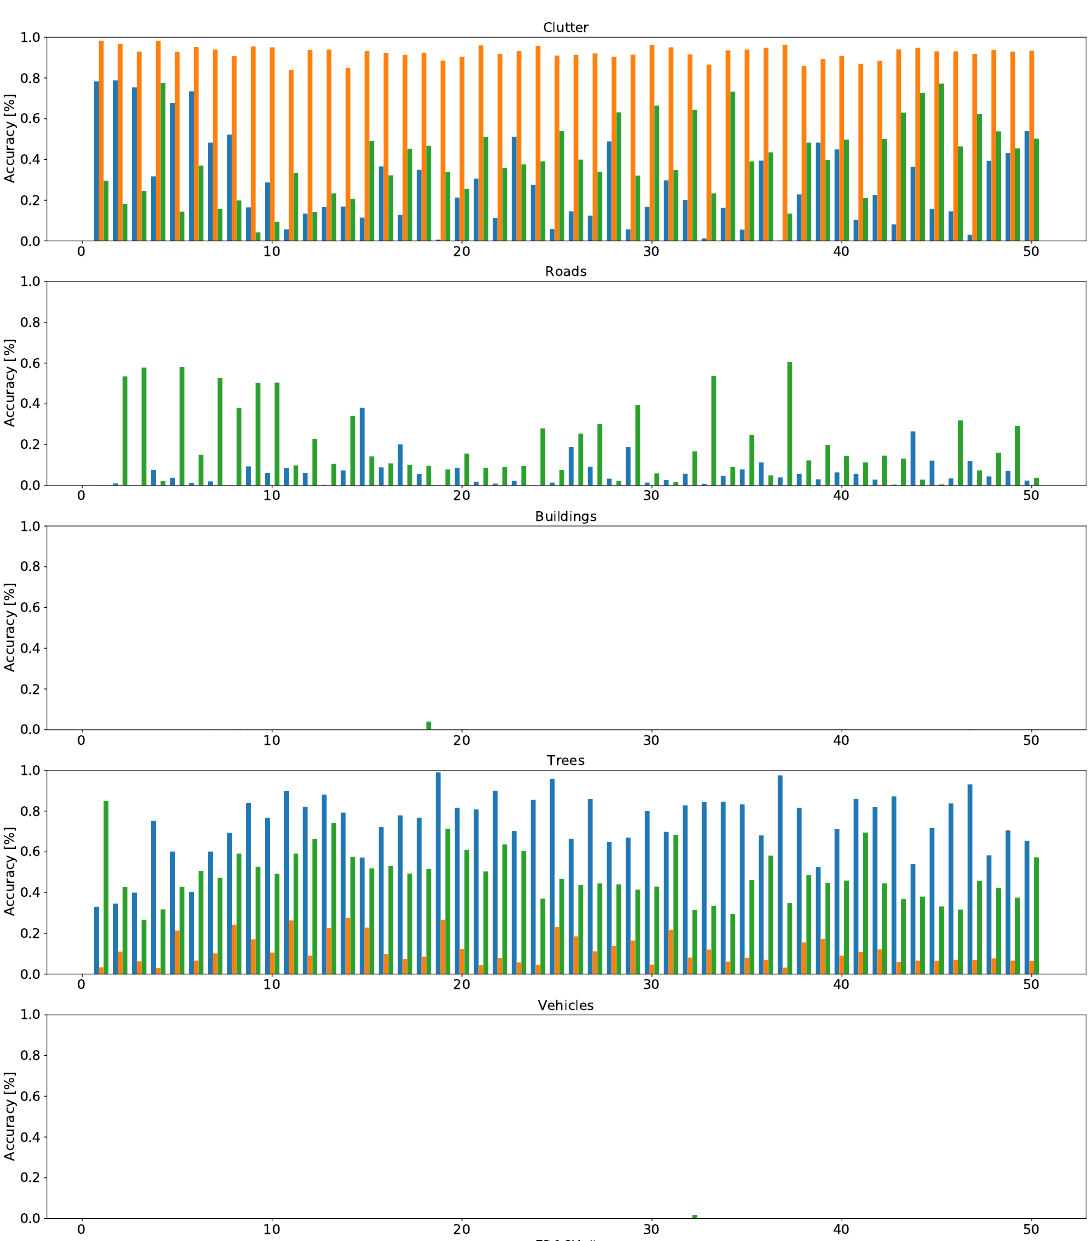
Figure 8. Per class accuracies for the GSCNN models after each